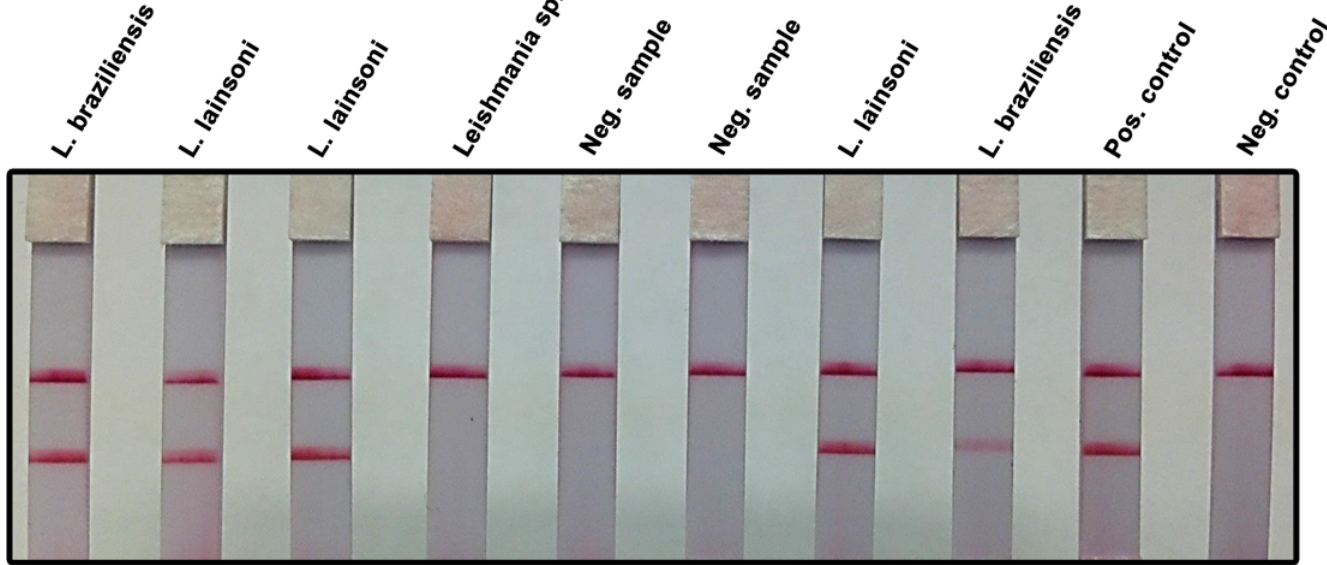
Fig 3. RPA-LF amplification of clinical samples using a simplified DNA extraction method. Samples from patients suspected of having cutaneous leishmaniasis were obtained by pressing Whatman FTA filter paper (two 6 mm diameter discs) over the dermal lesions. Two, 3 mm diameter papers were cut from the original samples using a punch, washed thrice with FTA washing reagent and twice with TE buffer pH 8. A 2.5 μ L aliquot was amplified by RPA and subsequently read using a lateral flow strip. Patients infected with Leishmania Viannia spp. ( L . lainsoni , L . braziliensis ) were readily detected. The test did not amplify a strain originally labeled as Leishmania sp. in NAMRU-6, Peru. Presumably, it did not belong to the Viannia subgenus as confirmed by real-time PCR at UTMB. There was agreement between NAMRU-6 and UTMB labs with regard to the negative clinical samples. L . lainsoni was used as positive control; the negative control was run without